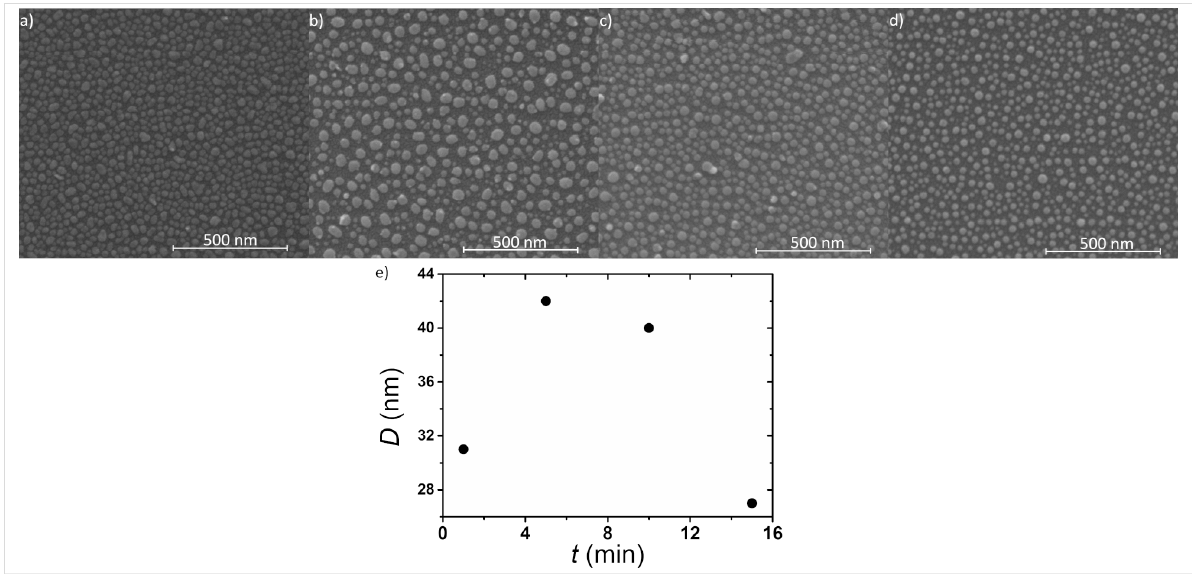
Figure 6: SEM images of a 2.8 nm thick film, annealed at a constant temperature of 550 °C for different periods of time: (a) 1 min, (b) 5 min, (c) 10 min and (d) 15 min; (e) average nanostructure diameter as a function of the annealing time.